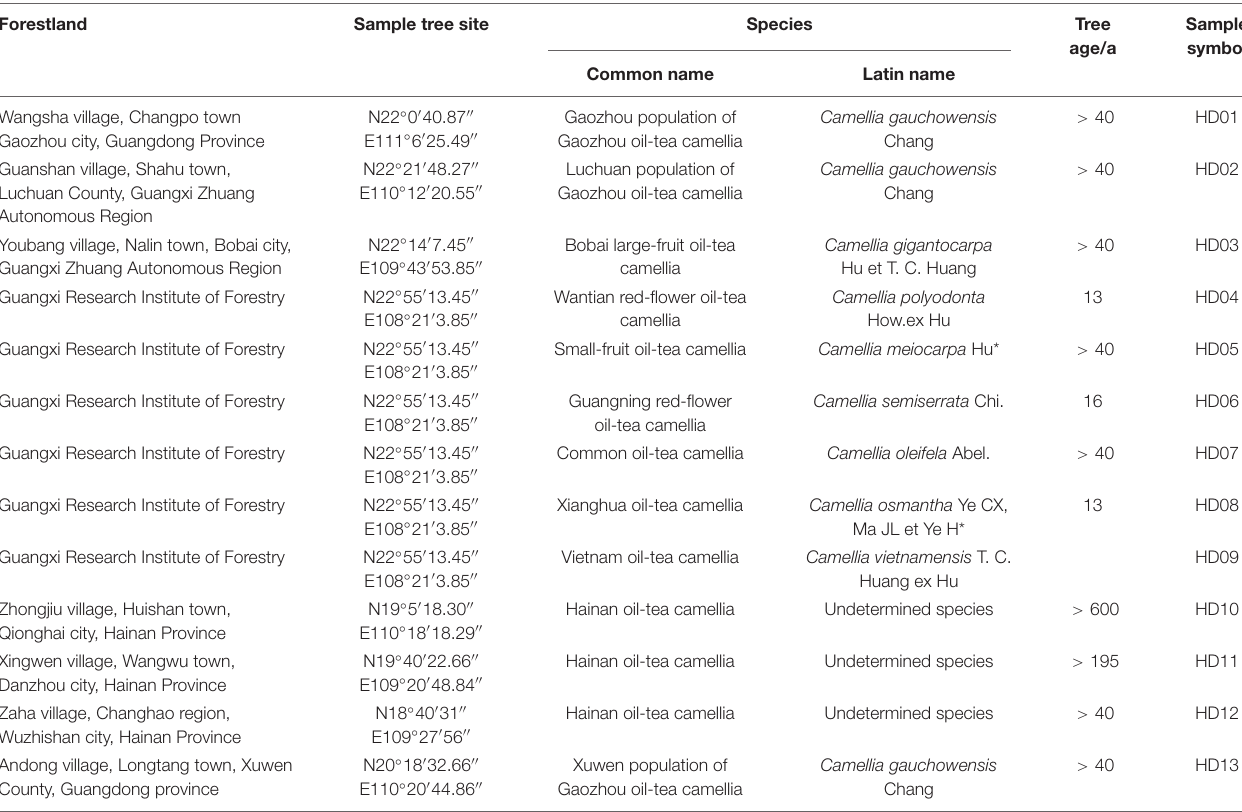
TABLE 1 | Basic information about the different oil-tea